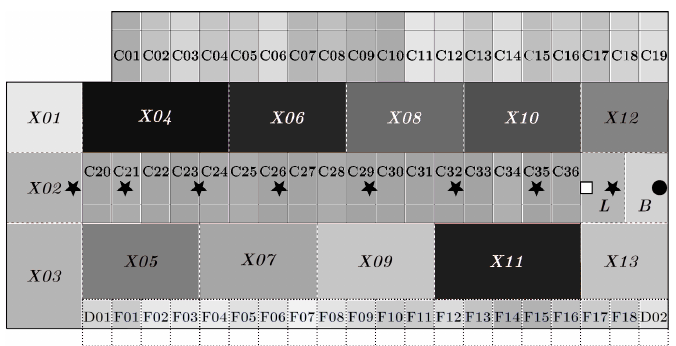
Figure 6. Visualisation of the usage of barn space on the example day 21 April 2019. The darker the barn segment depicted, the more time it was occupied by cows.